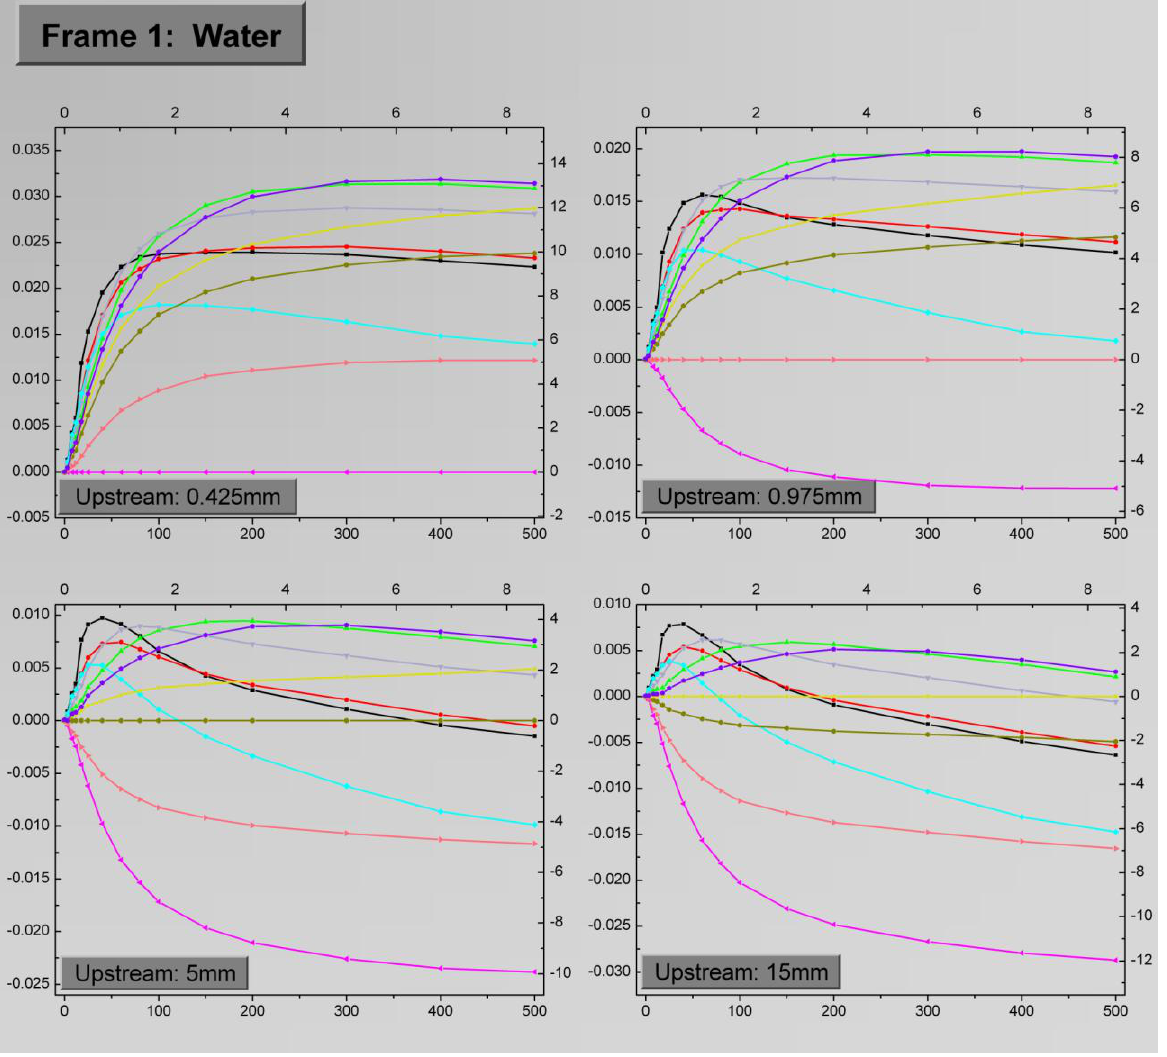
Figure 8. Frame 1 which describes sensor operation for water is shown. Each facet is associated to a different D up value, while each curve corresponds to a certain D loc . The axes quantities as well as the correspondence between the line colors and D loc are explained in Figure